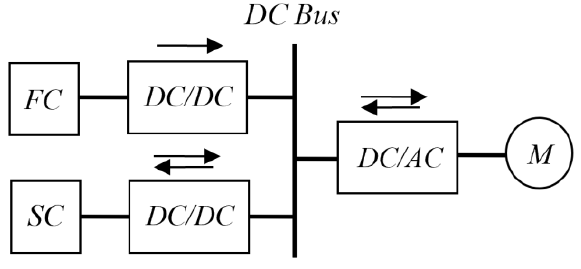
Figure 7. Combined vehicle system with FC as the main power source.